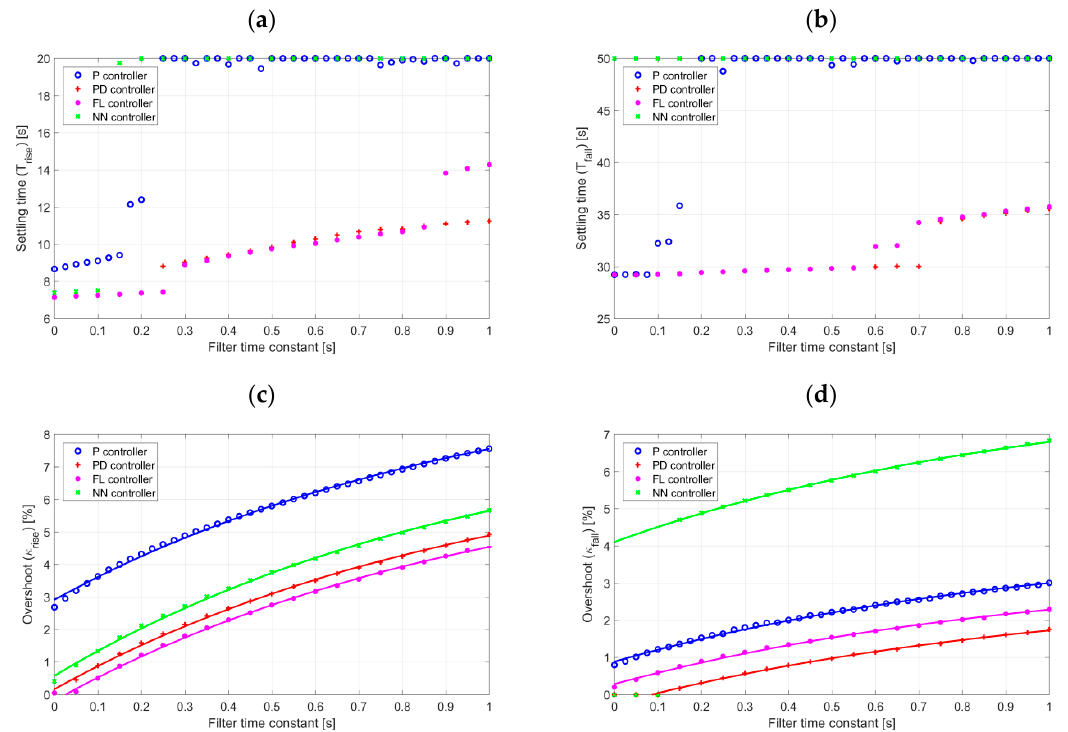
Figure 22. Control quality factors versus filter time constant. ( a ) settling time T rise , ( b ) settling time T fall , ( c ) overshoot κ rise , and ( d ) overshoot κ fall .